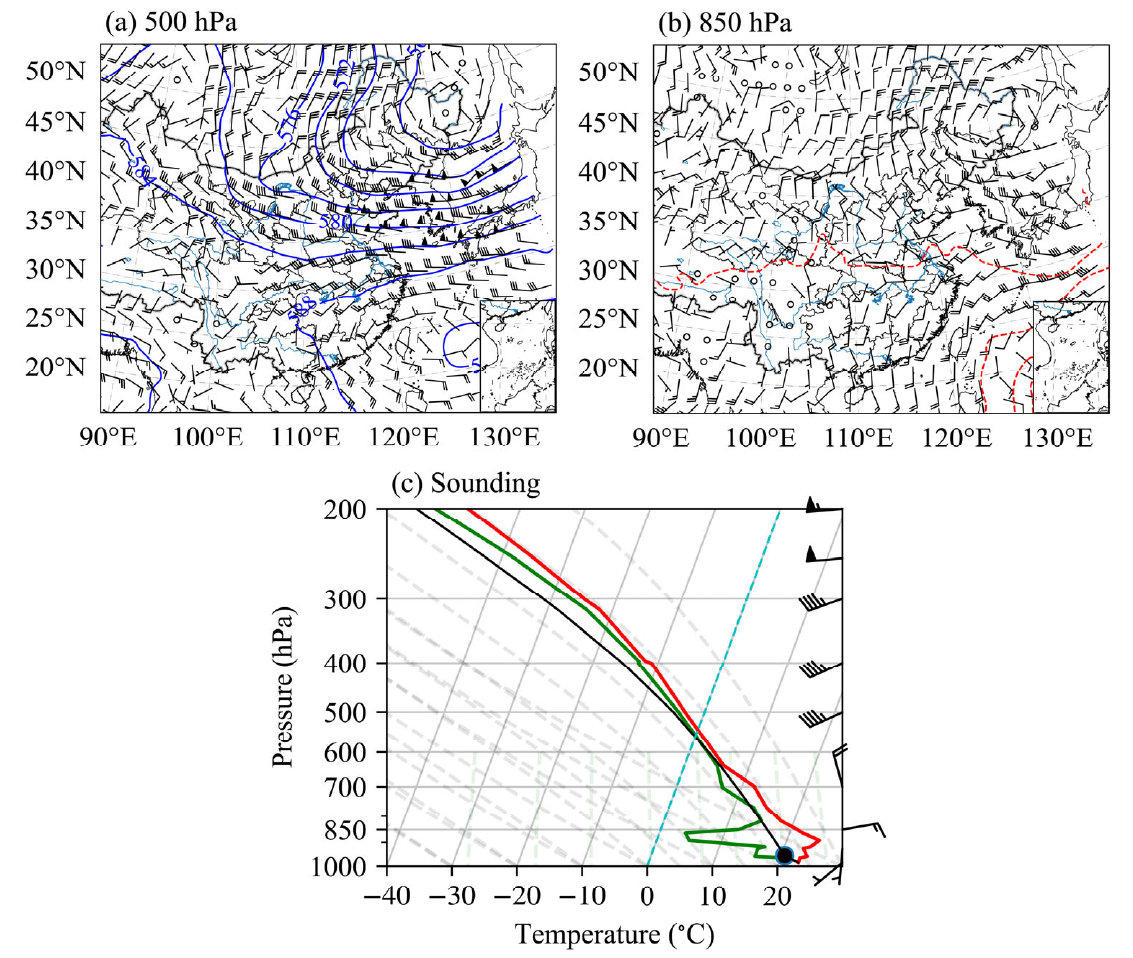
Figure 4. Weather charts from the fifth ‐ generation ECMWF atmospheric reanalysis of the global climate (ERA5, 0.25° × 0.25°) data and the sounding chart from observation at 1200 UTC 11 July 2014, ( a ) 500 hPa and ( b ) 850 hPa geopotential height (blue solid lines, units: dagpm) and wind field (barbs, units: m/s), the red dashed line was the potential temperature of 345 K which indicated the location of MeiYu front in ( b ). ( c ) The sounding chart was taken at Nanyang station. The green line represents the dew point temperature profile, the black line represents the lifting curve, the red line represents the temperature profile and the black represents the lifting condensation level in ( c ). The location of Nanyang station is shown in Figure 1.